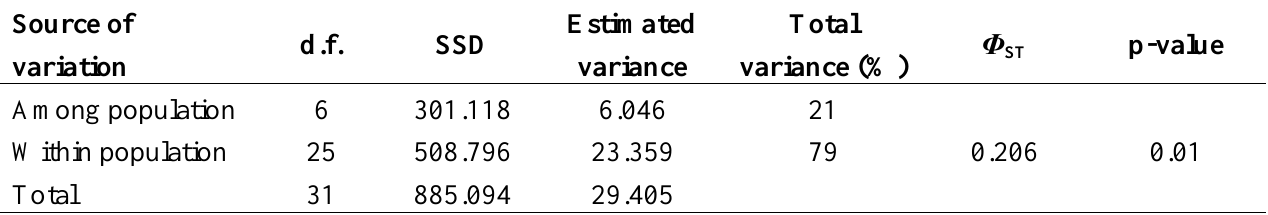
Table 4. Hierarchical analysis of molecular variance (AMOVA) within/among C.